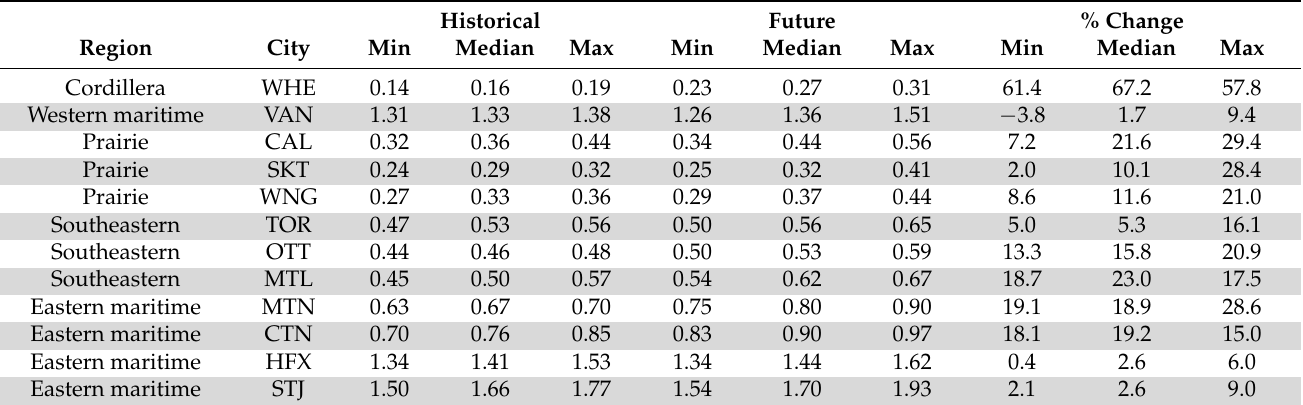
Table 3. Summary statistics and projected change in annual sum of wind-driven rain (ton/m 2 ).